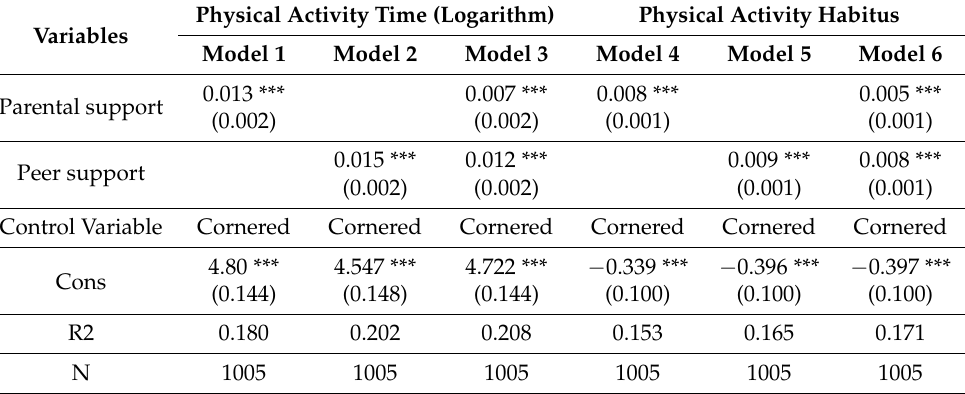
Table 8. Results of robustness